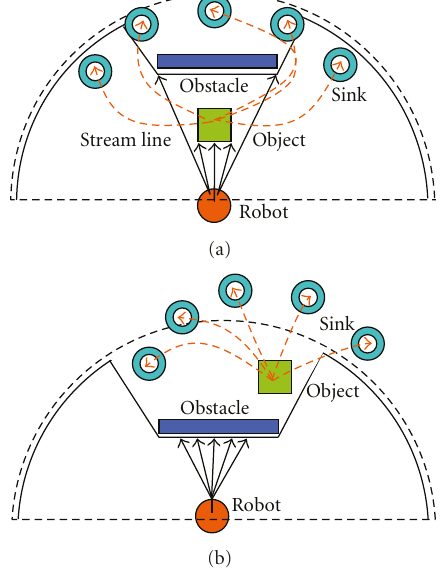
Figure 6: Localization and stream field-based tracking in (a) fully observable case and (b)